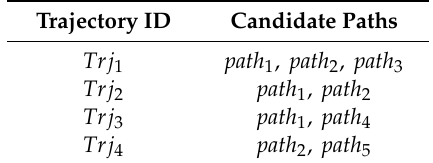
Table 2. Trajectories and the corresponding candidate paths.